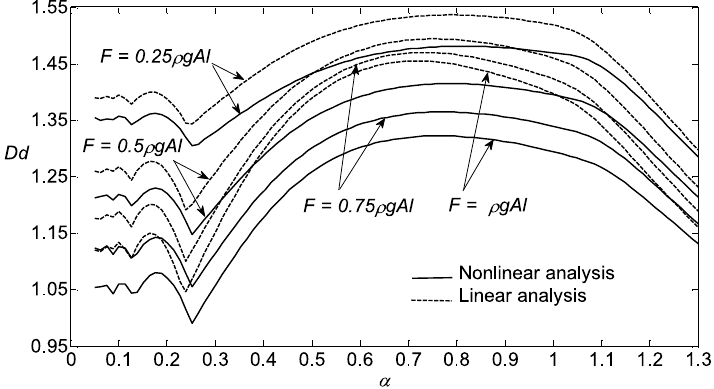
Fig. 4. Variation of dynamic magni fi cation factor ( D d ) vs. α for an inclined self-weight Timoshenko beam with θ = 36 ◦ under motion of a concentrated moving force of F (N). (—–) nonlinear analysis, ( ) linear